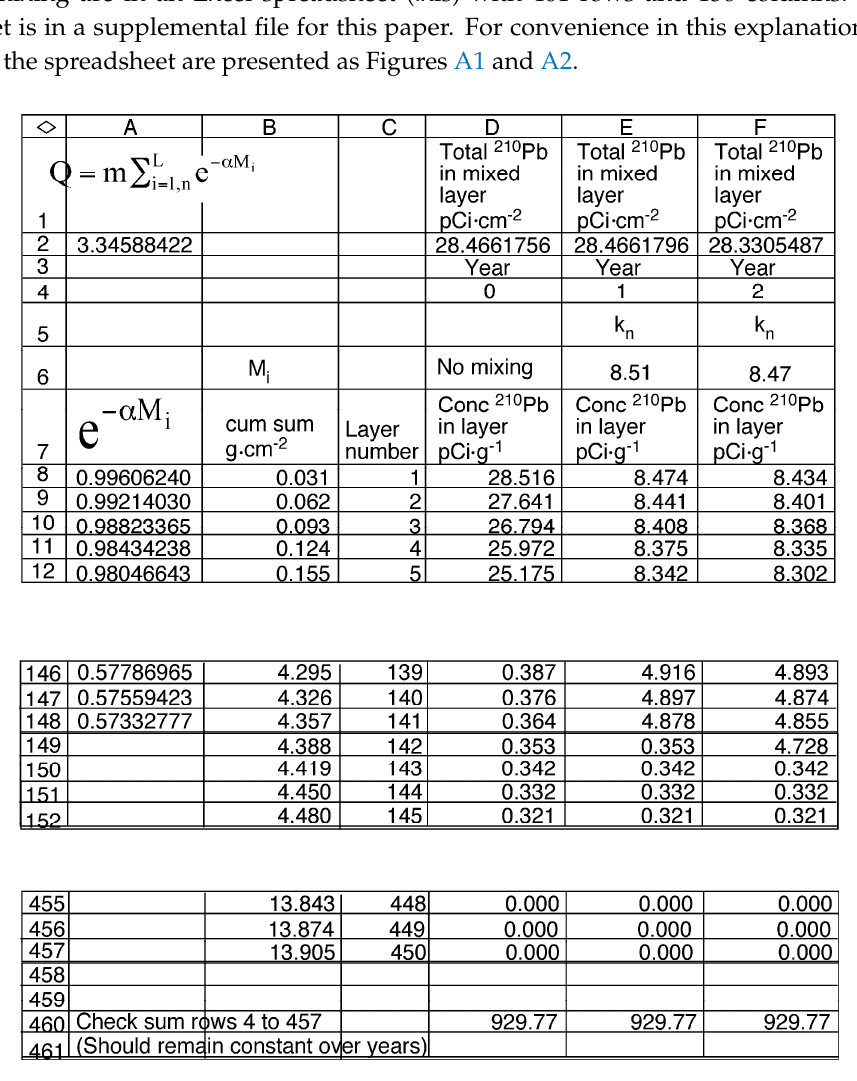
Figure A1. Portions of the Excel spreadsheet for the first 6 columns.